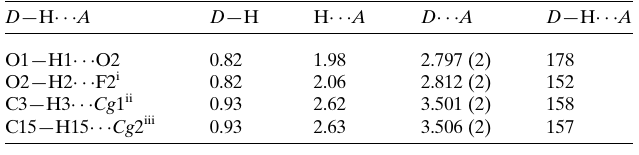
Table 3 Experimental details. Crystal data Chemical